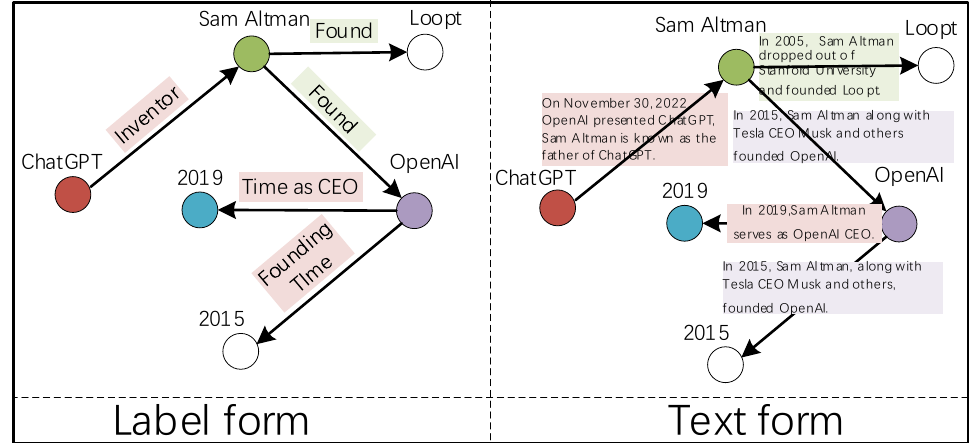
Figure 1. Label form and text form structure diagram.